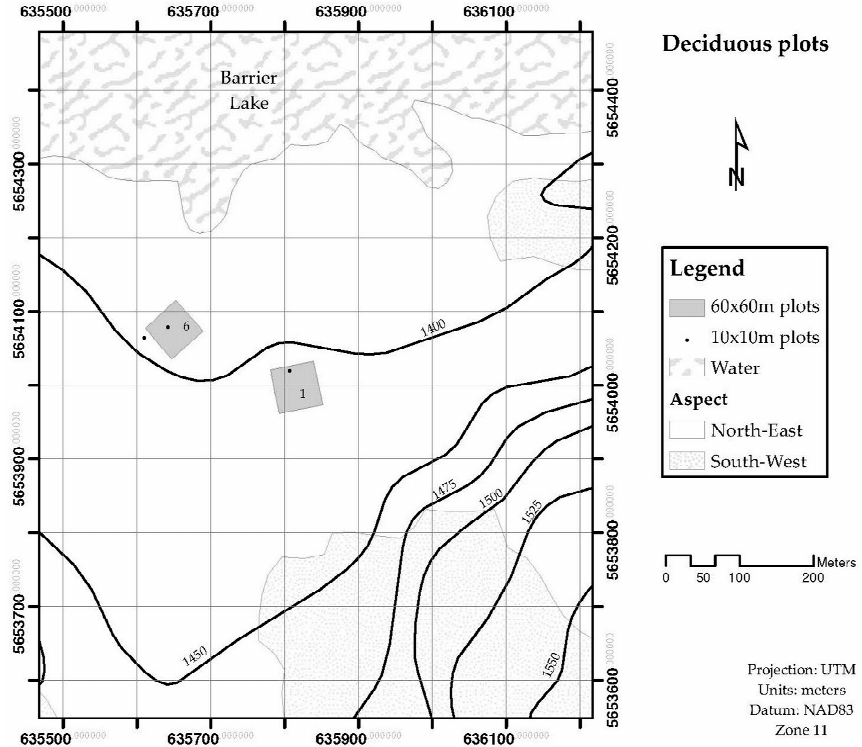
Figure 2. Geographical location of deciduous plots. The plots are in the Sibbald areas, south-east of Barrier Lake (Kananaskis Country).